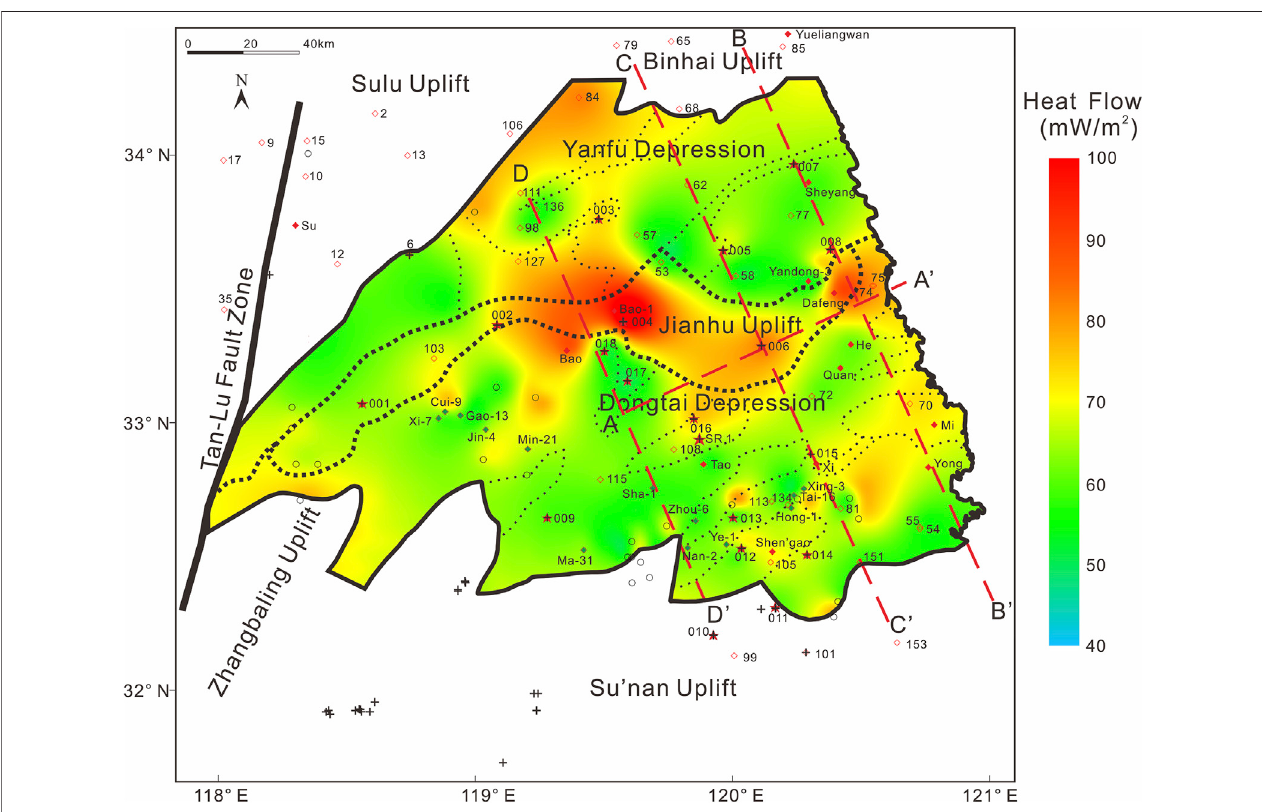
FIGURE 6 | Heat fl ow distribution map of the North Jiangsu